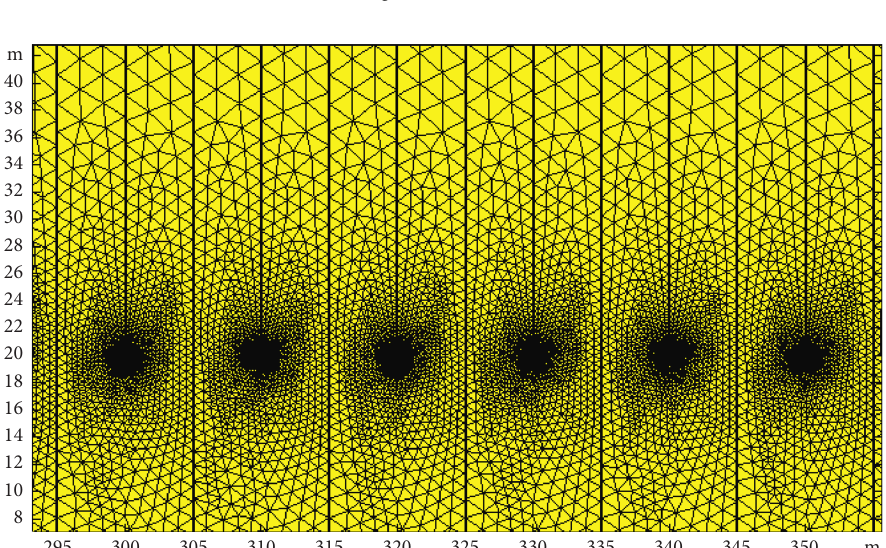
Figure 2: Meshing